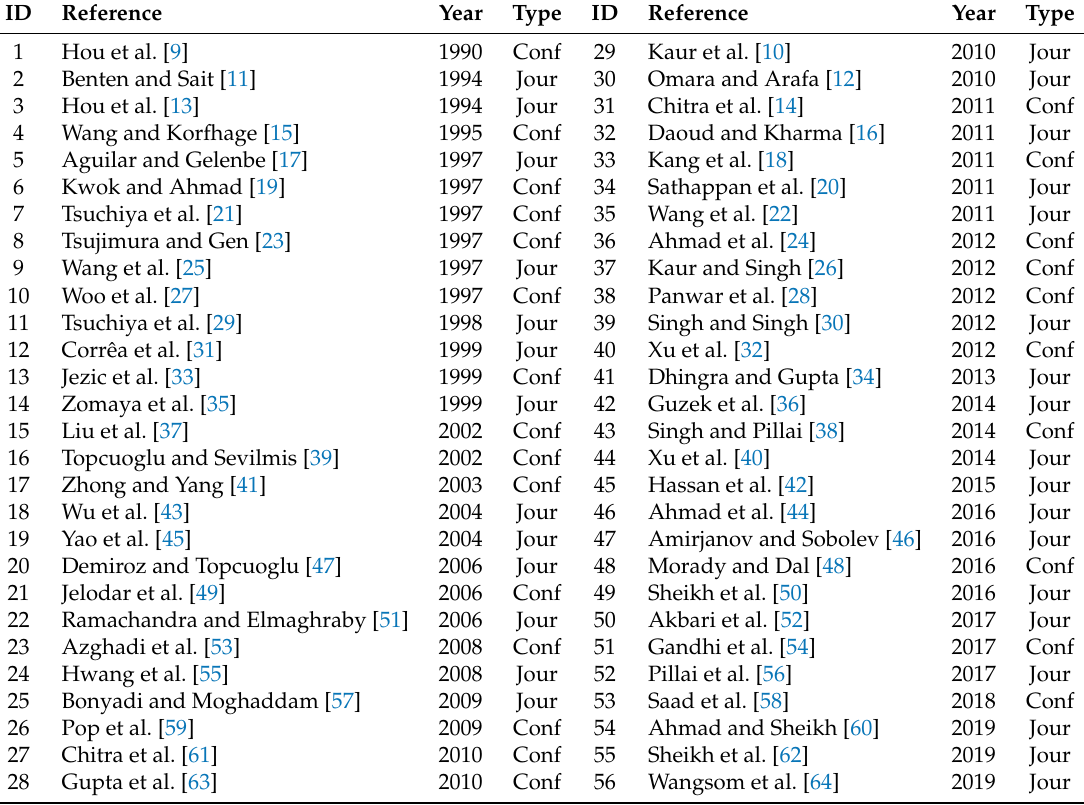
Table 3. Summary of the collection in chronological order. We employ the ID along this paper to referee the